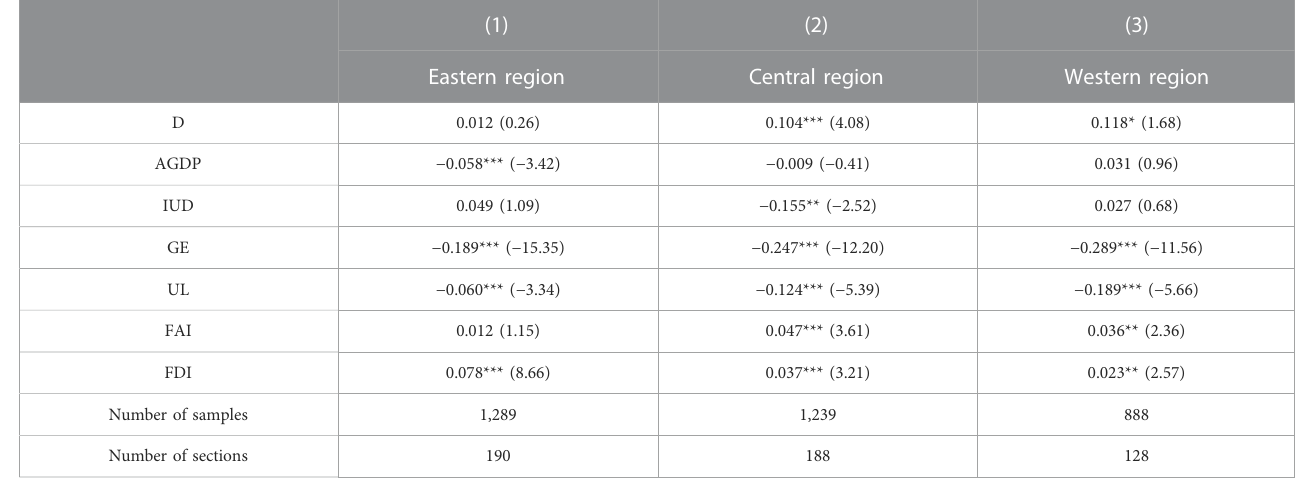
TABLE 10 Regional distribution heterogeneity analysis.